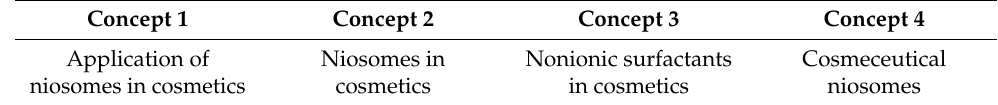
Table 2. Key concepts identified for use in the databases.